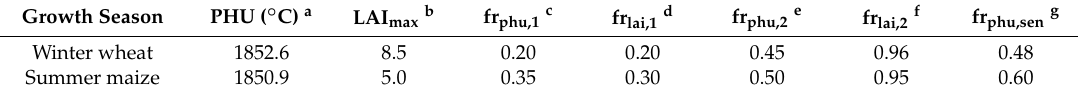
Table 3. LAI parameters for winter wheat and summer maize used in the simulation.